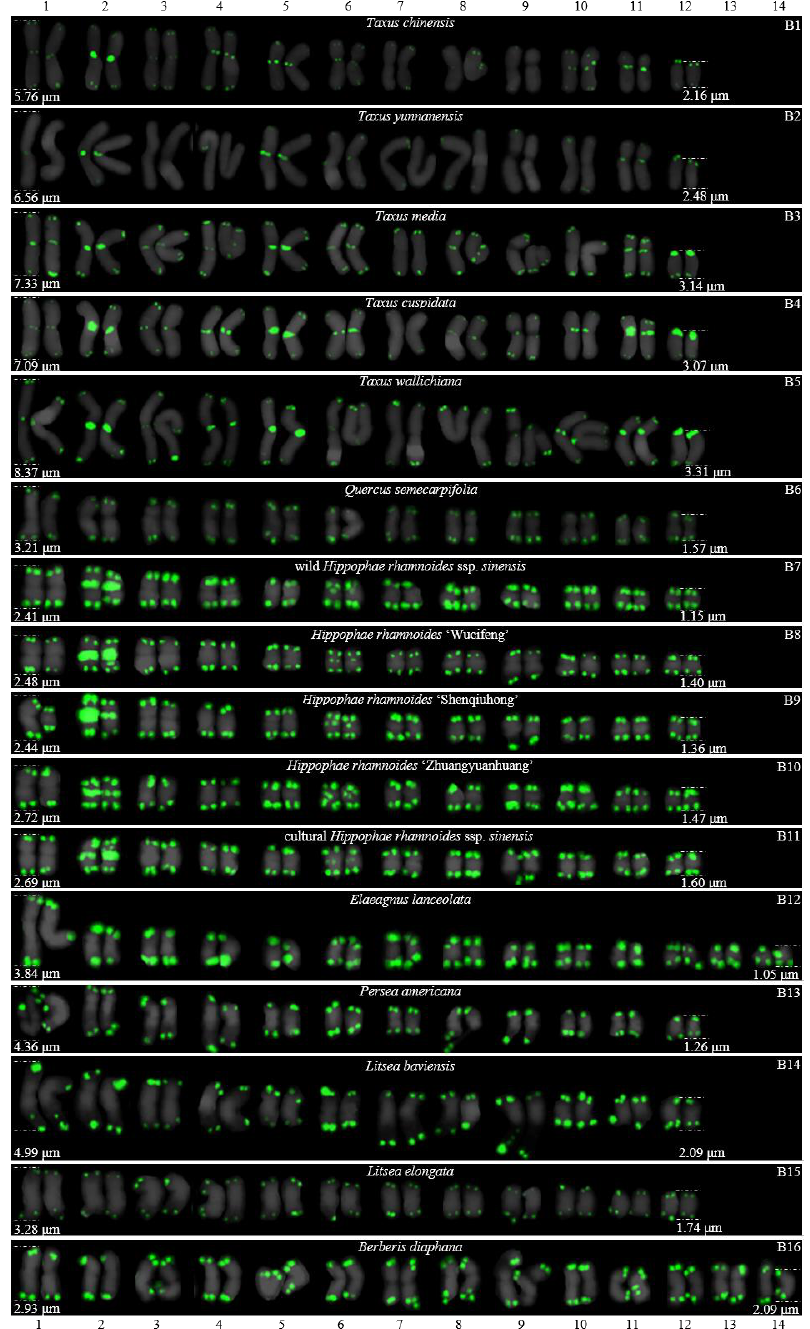
Figure 5. FISH karyograms of the 16 woody plants cutting from Figure 2. Oligo-probe (AG 3 T 3 ) 3 is exhibited by green signals. The upper/lower numbers (1 – 14) represent the chromosome pairs. The first/last chromosome of each plant were used to calculate the chromosome length: ( B1 ) T. chinensis